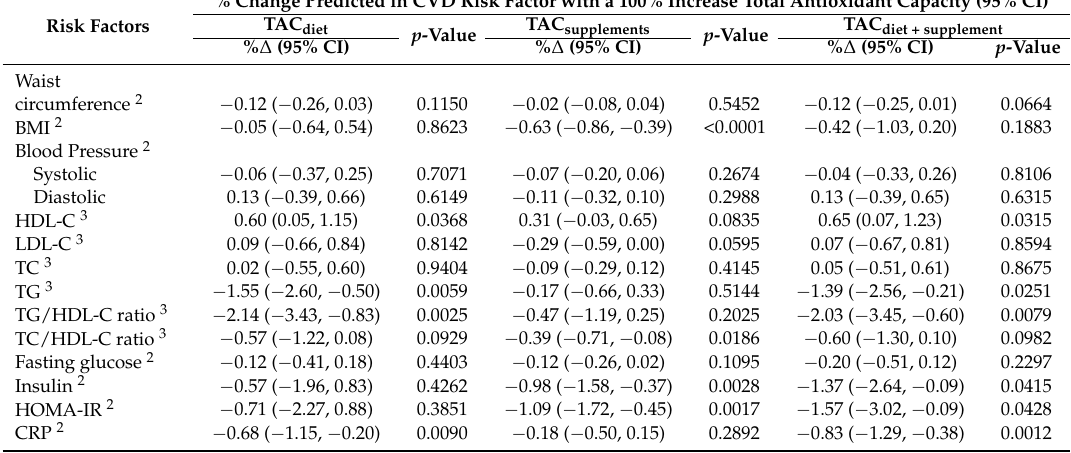
1 Multivariate linear regression analysis of cardiovascular disease risk factors. Values are changes in percentages (%) of cardiovascular disease risk factors with a 100% increase of TAC; 2 model 1: Adjusted for total energy intake, age, gender, ethnicity, physical activity, PIR, smoking, alcohol consumption, blood pressure medication, diabetes medication, and BMI. BMI was adjusted for all variables except BMI; 3 model 2: Model